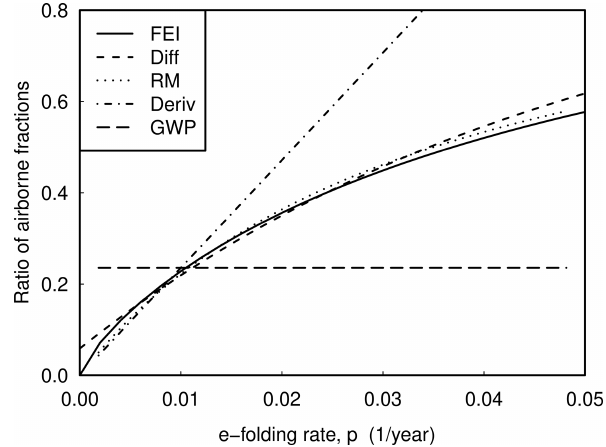
Figure 1. Ratio of airborne fractions for CH 4 relative to CO 2 as defined or assumed for various metrics. The solid curve shows the forcing equivalent index (FEI), which acts as a reference. The global warming potential (GWP) treats this ratio as independent of timescale (Eq. 16); the chain line for the “Deriv” case treats the timescale dependence as proportional to the inverse timescale (Eq. 19); the shorter dashes of the “Diff” curve (Eq. 21) more closely approximate FEI. The dotted line is an empirical reduced model (RM) approximation (Eq. 23) to FEI. These curves can also be interpreted as the Laplace transforms of the operations that de- fine the equivalence in the time domain.